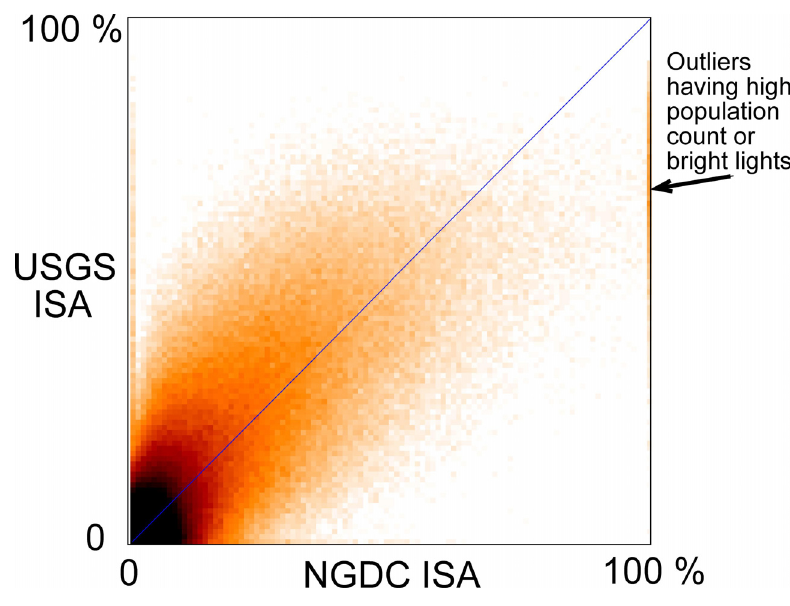
Figure 6. NGDC’s predicted ISA values versus the USGS reference values for the conterminous USA.